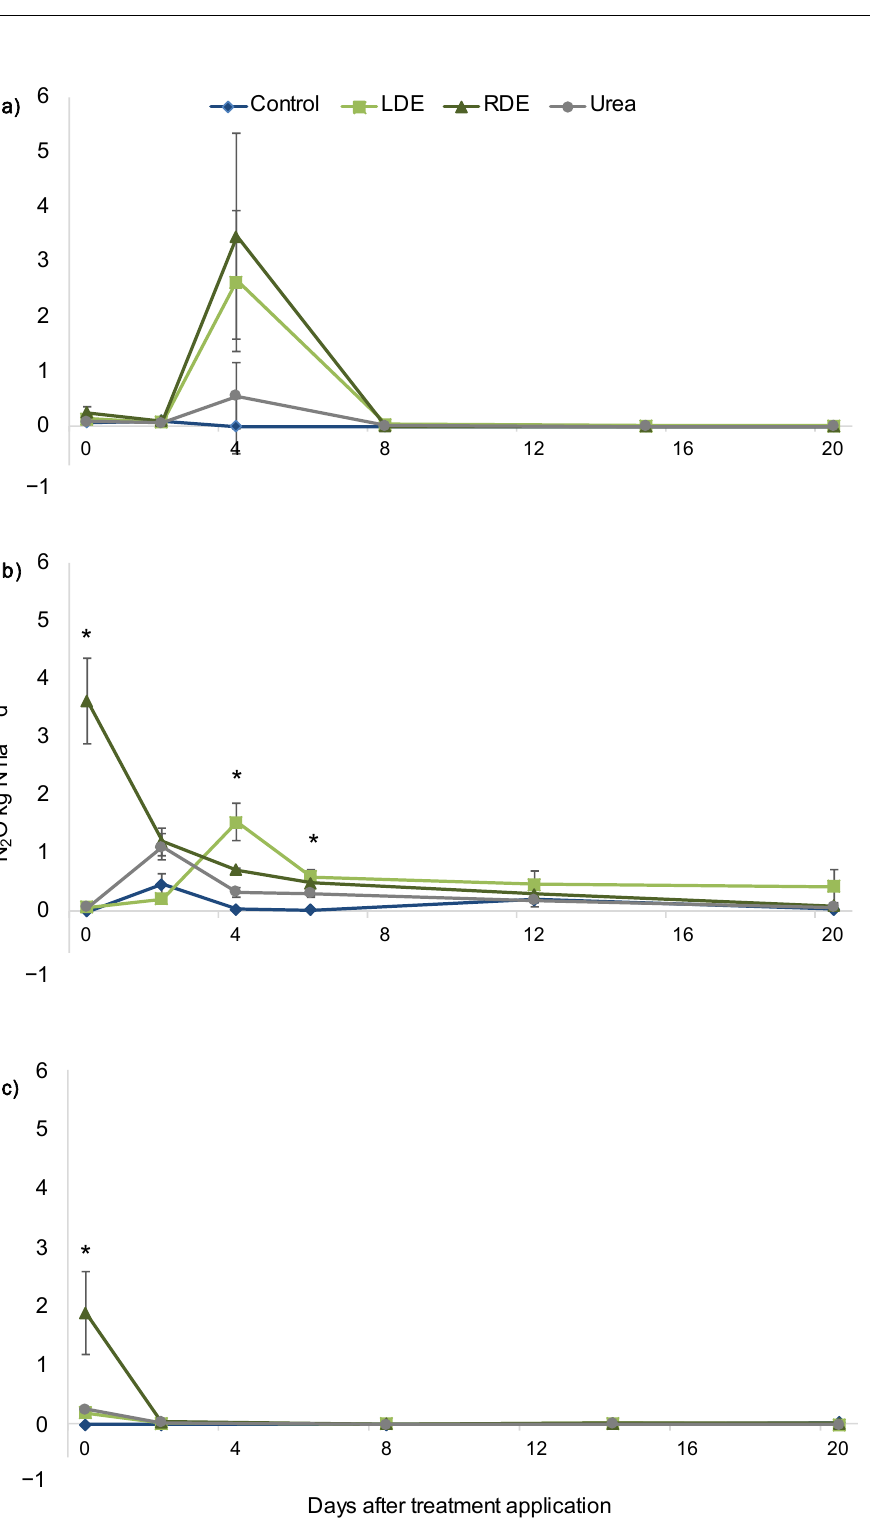
Figure 1. Evolution of N 2 O fluxes after September ( a ), January ( b ), and March ( c ) application of Dairy effluents (DE), urea, or non-amended control (mean n = 5 ± S.E). (November application was not measured). Asterisks indicate sampling dates with significant differences within treatments at p <